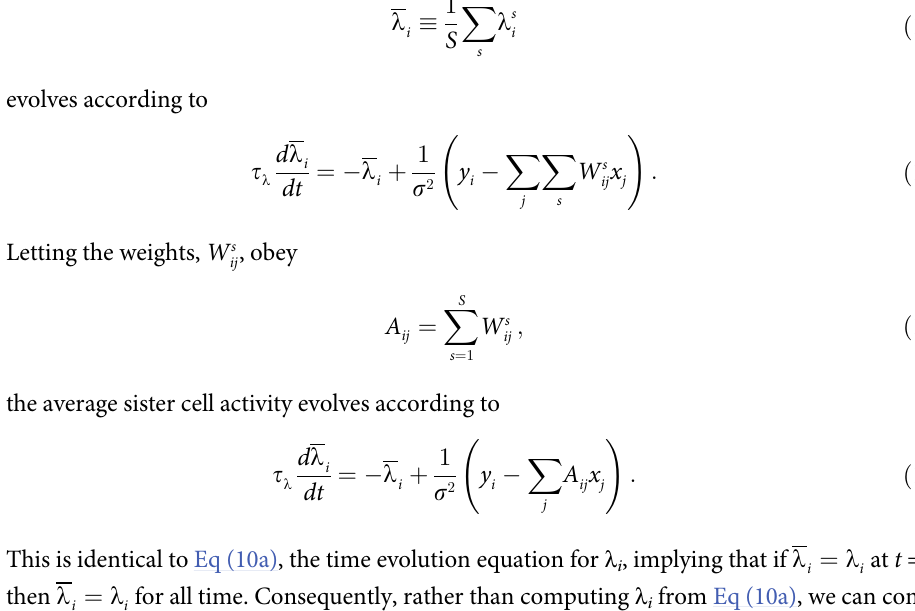
. (B) A ij ¼ A = S . The sister mitral cells ij ij